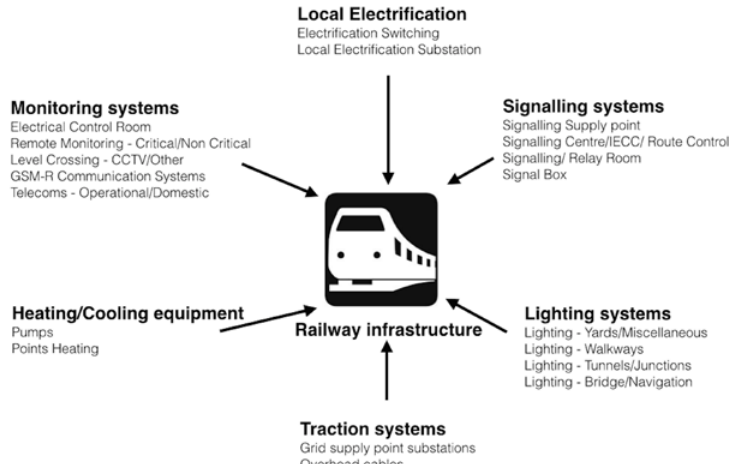
Figure 4. Different components of the railway